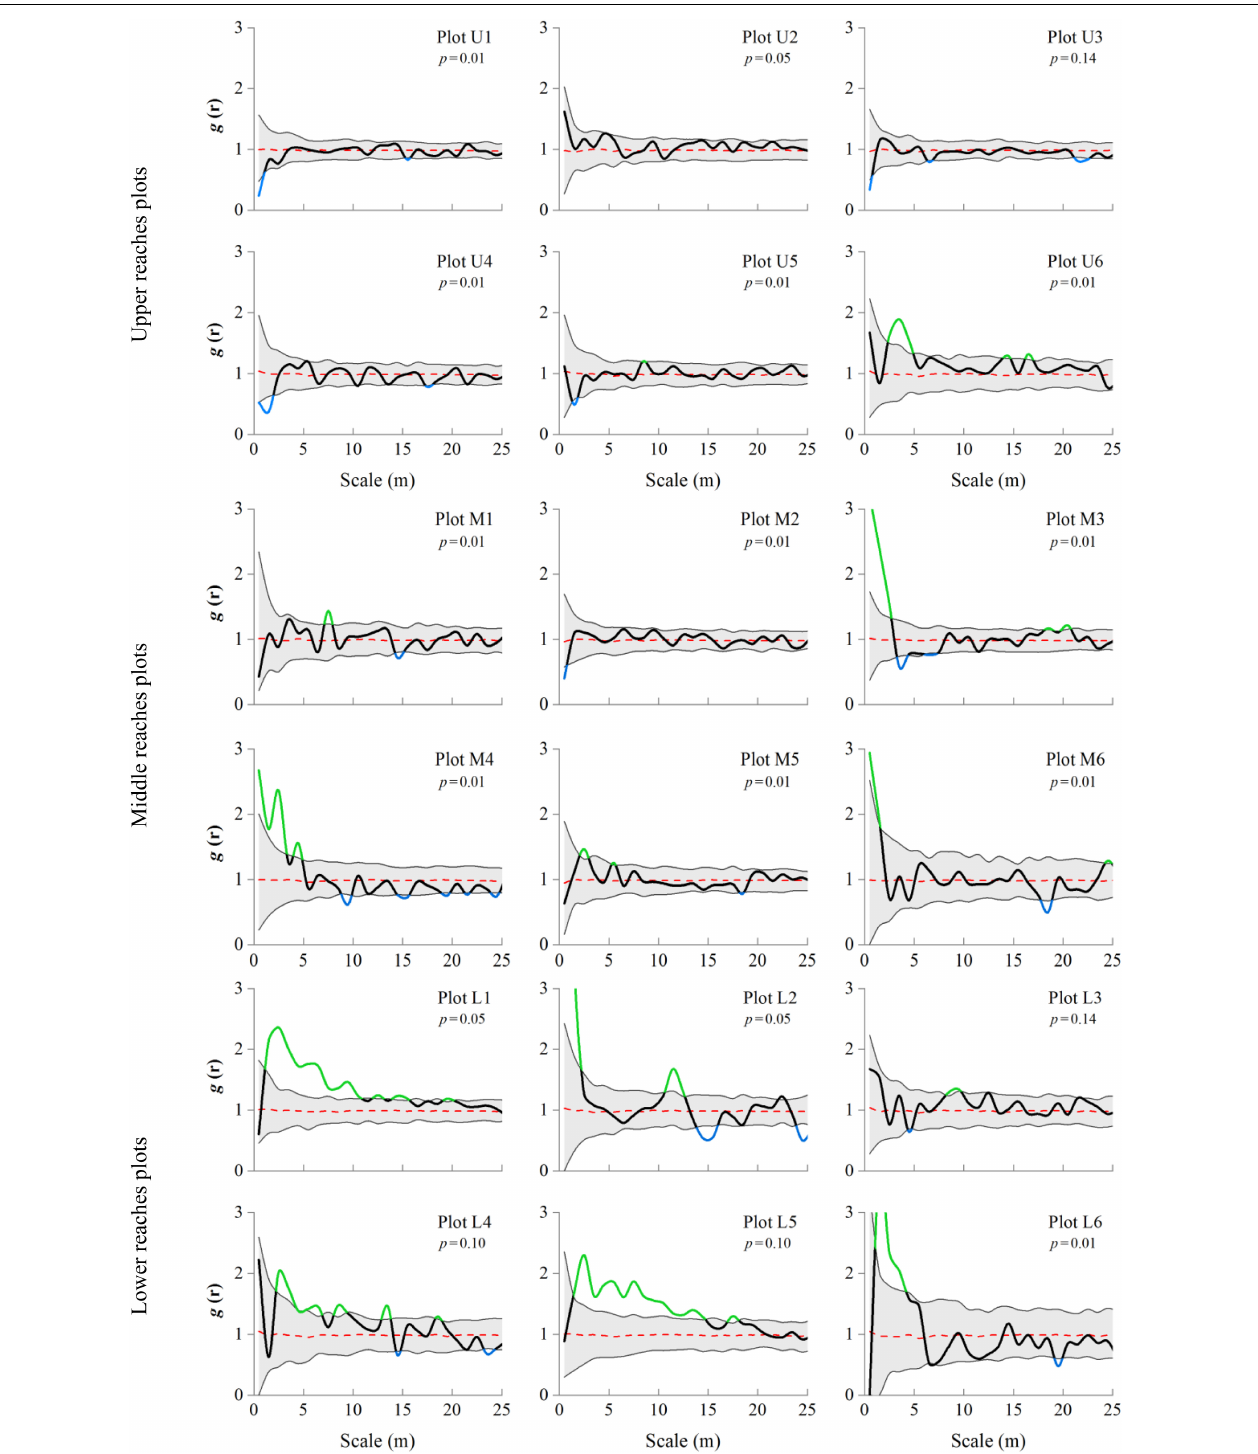
FIGURE 6 | Spatial distribution patterns of P. euphratica trees across different river transects. Representation of pair correlation g( r ) analysis using complete spatial randomness (CSR) null models assessed all forest plots. Bold lines indicate the g( r ) function value, green indicates values above CSR model confidence envelopes (aggregated), blue indicates values below envelopes (regular), and black indicates values within the envelopes (random), and shaded areas indicate the Monte Carlo envelopes 99% confidence interval.